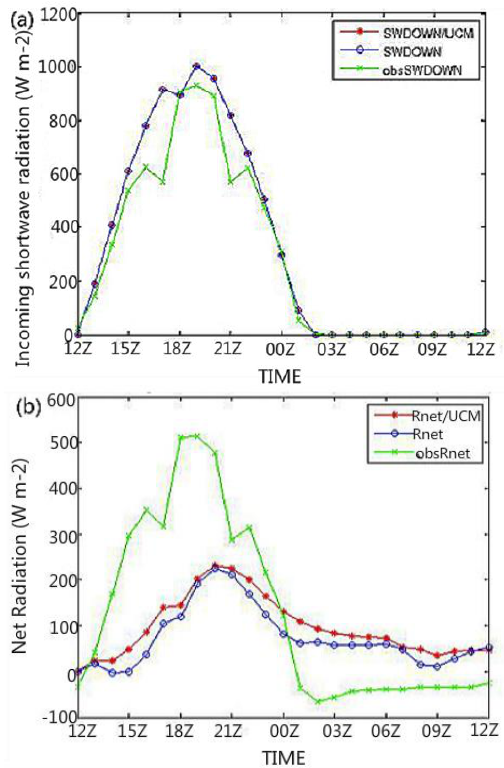
Figure 15. ( a ) The WRF-simulated downward shortwave radiation and ground-observed downward shortwave radiation in OKC; ( b ) The WRF-simulated net radiation and ground-observed net radiation in OKC.